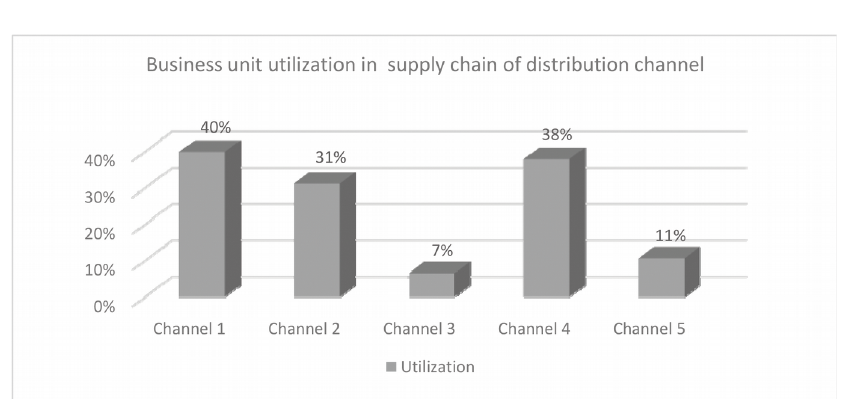
Figure 6. Business unit utilization in supply chain of distribution